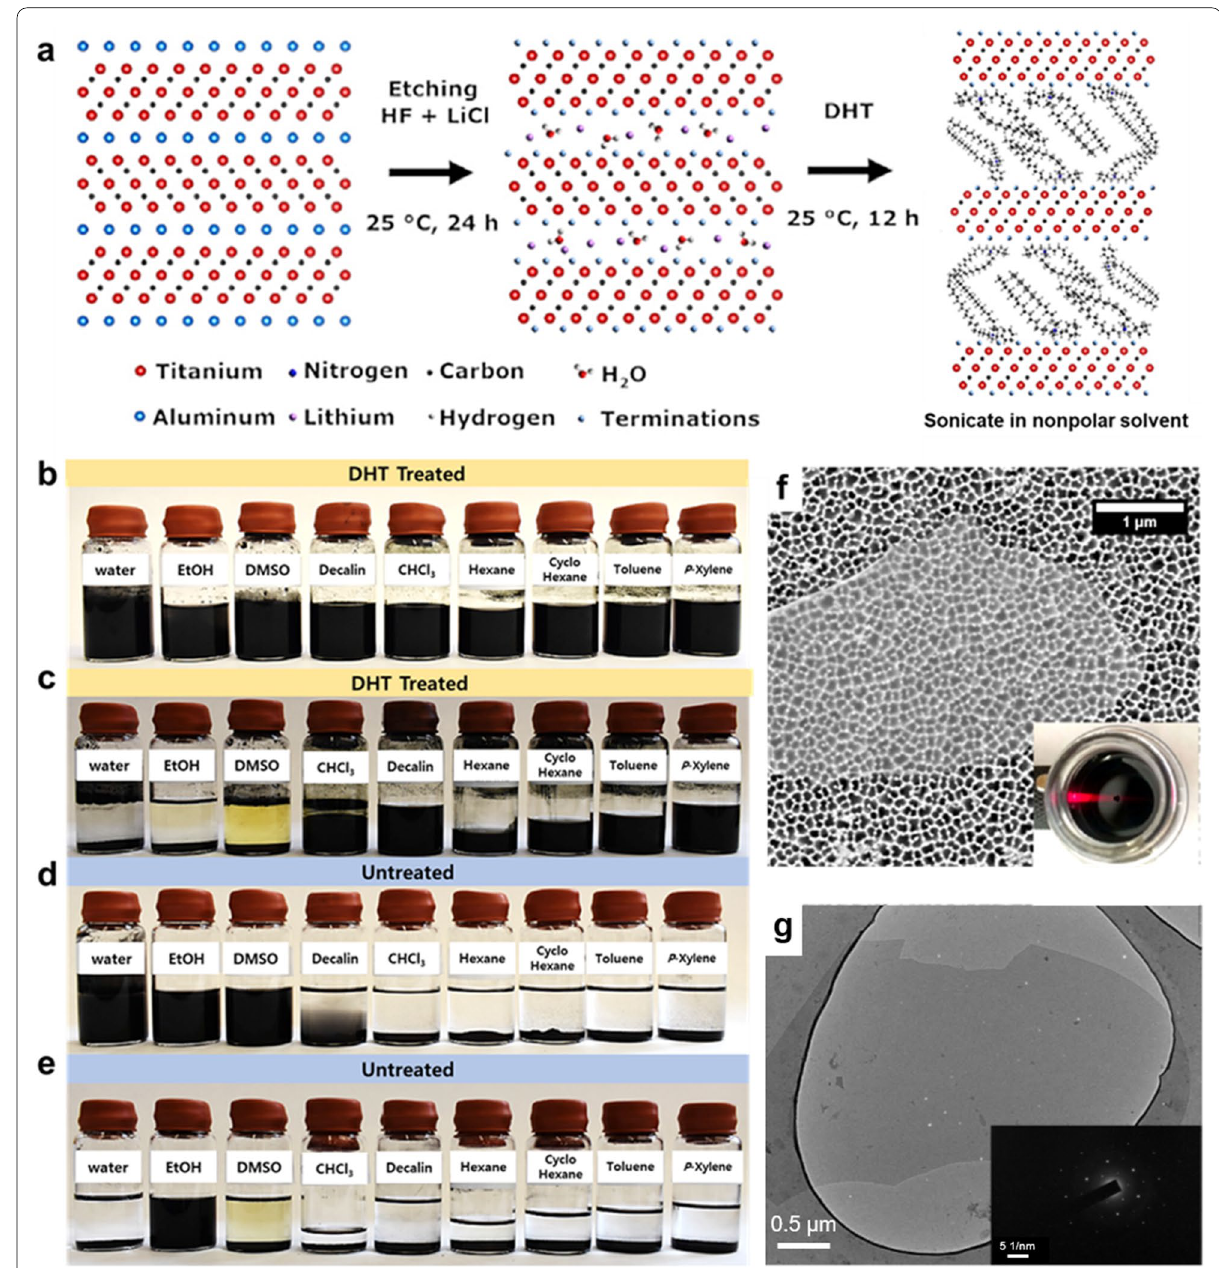
Fig. 12 a Schematic illustration of simultaneous interfacial chemical grafting reaction and phase transfer for preparing a stable nonpolar Ti 3 C 2 T x dispersion. Photographs of DHT-treated Ti 3 C 2 T x suspensions in polar (first three vials) and nonpolar solvents b right after sonication and c after 10 days. Photographs of Ti 3 C 2 T x suspensions d right after sonication and e after 10 days. f Typical SEM micrograph of a drop of DHT-treated Ti 3 C 2 T x dispersed in a cyclohexane suspension cast on a porous alumina substrate. Scale bar is 1 μm. Inset shows the Tyndall effect. g TEM micrograph of a drop of a DHT-MXene-decalin suspension after 10 days. Scale bar is 0.5 μm. Inset shows selected area diffraction pattern with a scale bar of 10 nm − 1 . a – g Reproduced with permissions from ref. [62]. Copyright (2020),